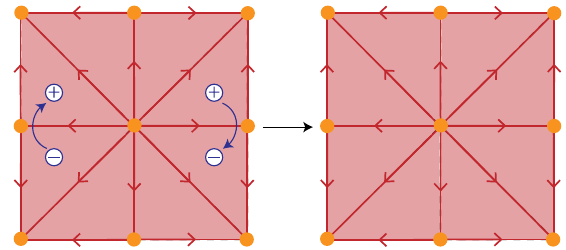
FIG. 17. Illustration of annihilation process of gapless points. Here, white solid circles denote gapless points, and (cid:3) represent the sign of the winding numbers.